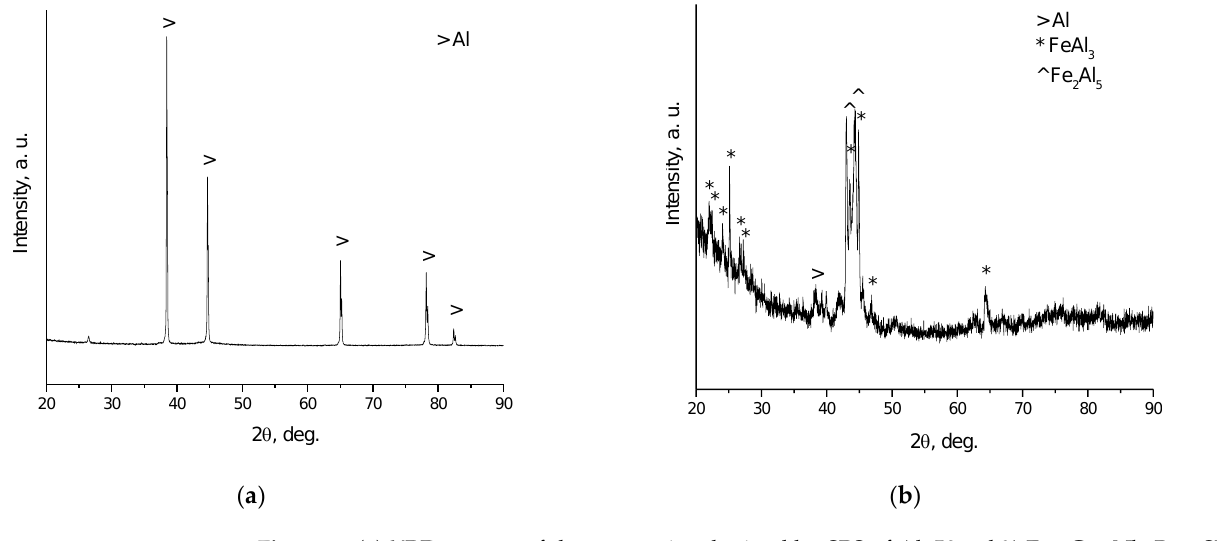
Figure 9. ( a ) XRD pattern of the composite obtained by SPS of Al – 50 vol.% Fe 66 Cr 10 Nb 5 B 19 . SPS conditions: temperature — 500 °C, holding time — 3 min, applied pressure — 40 MPa. ( b ) XRD pattern of the composite obtained by SPS and further annealed in vacuum at 620 °C for 2 h.